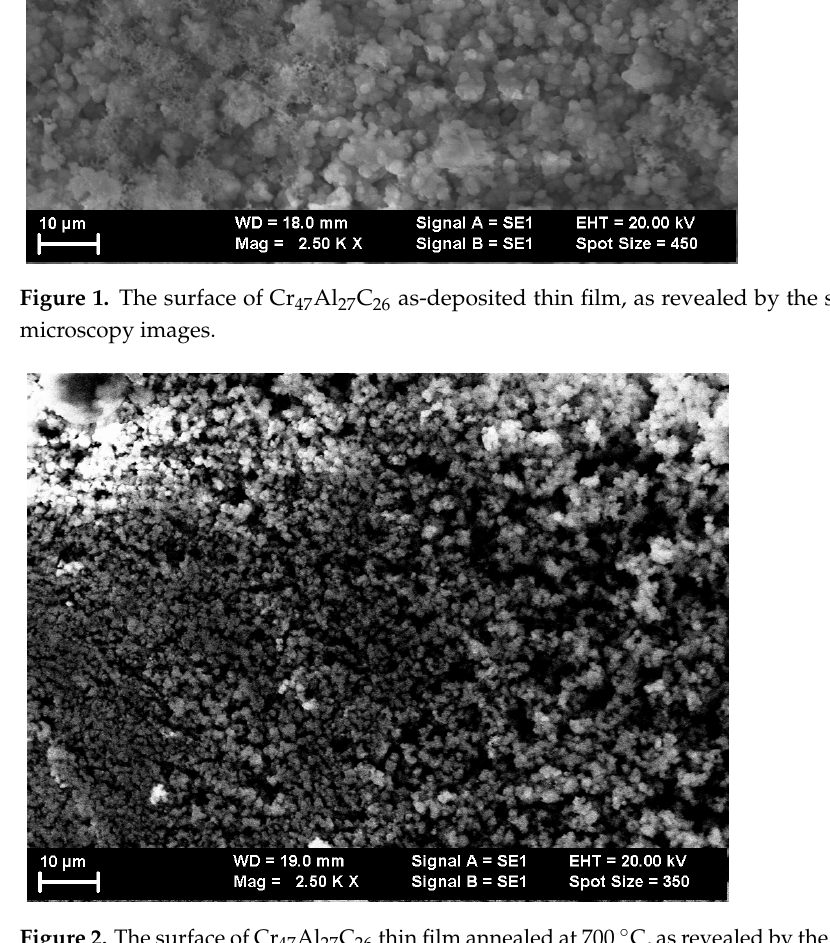
Figure 2. The surface of Cr 47 Al 27 C 26 thin film annealed at 700 °C, as revealed by the scanning electron microscopy images.